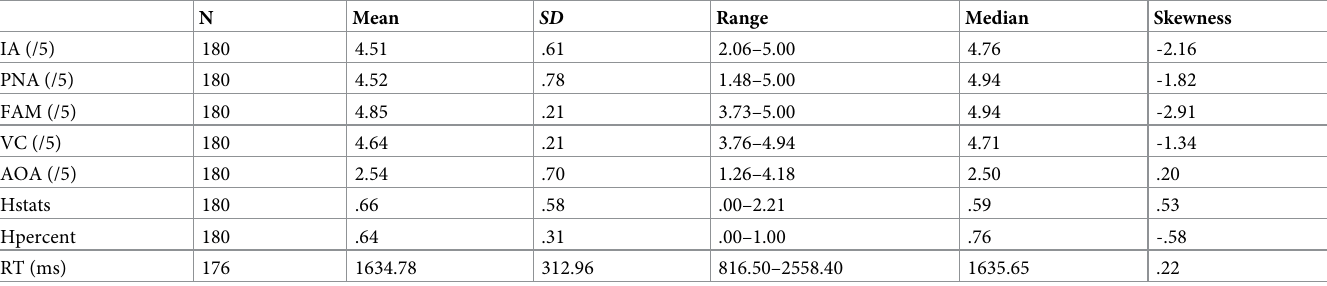
Table 4. Descriptive statistics of rating and confrontation naming